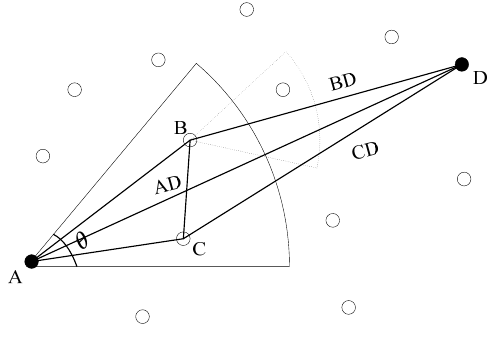
Figure 5. The principle of FBR.